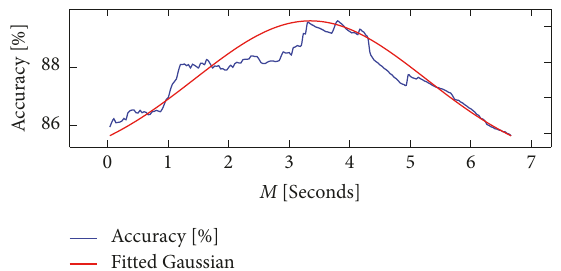
Figure 8: System accuracy evaluated at different values of history intervals 𝑀 . At 𝑀 = 1 , current camera input image is solely used for distraction classification; no context is used. For 𝑀 > 1 , we average predictions of 𝑀 frames to obtain distraction in the current frame. Up to a certain threshold, the more context incorporated in the prediction, the more accurate and robust the system. After that threshold, contextual information in the past is no longer relevant. Best accuracy is achieved at 𝑀 = 3.35 seconds, which is the average of the fitted Gaussian